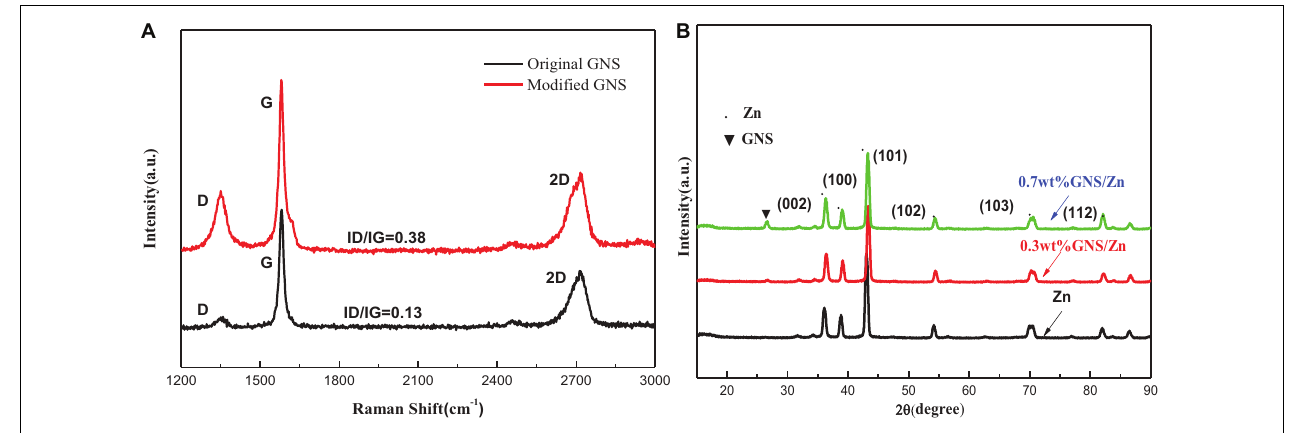
FIGURE 4 | (A) Raman spectra of original GNS and GNSafter surface treatment, + (B) XRD of pure zinc and GNS/Zn composites.